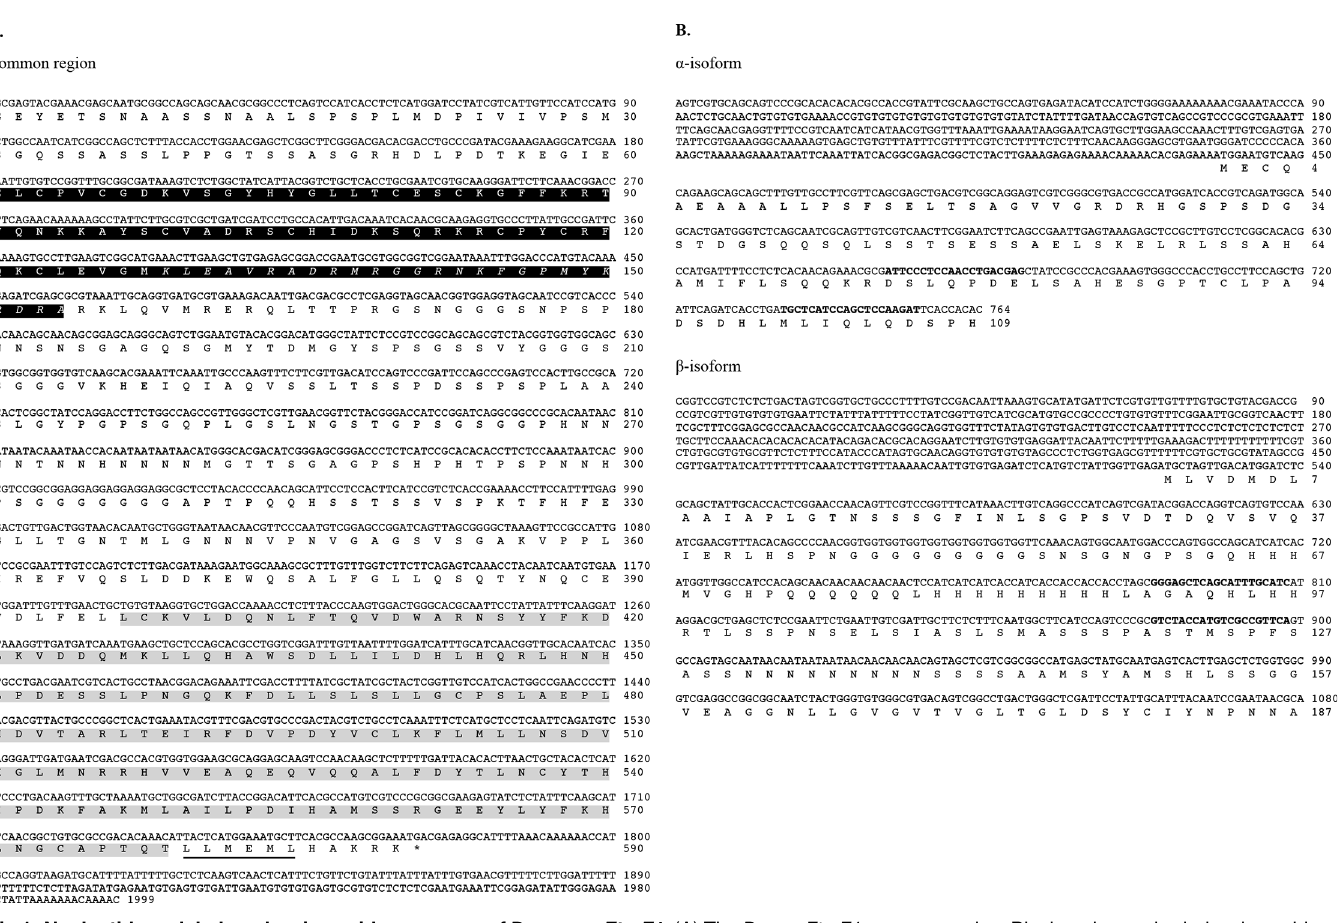
Fig 1. Nucleotide and deduced amino acid sequences of D . magna Ftz-F1 . (A) The DapmaFtz-F1 common region. Black and grey shaded amino acids indicate the putative DNA-binding domain (DBD) and ligand-binding domain (LBD) respectively, based on the alignment of amino acid sequences of signature domains. The Ftz-F1 box (italicized) and the activation factor-2 (AF-2) core (underlined) motifs are indicated. (B) Nucleotide sequence of DapmaFtz-F1 isoform-specific regions. Deduced amino acid sequences starting from the first methionine for each isoform are also indicated. Locations of the primers used in qRT-PCR are emboldened. Numbers on the right indicate the nucleotide and amino acid positions.